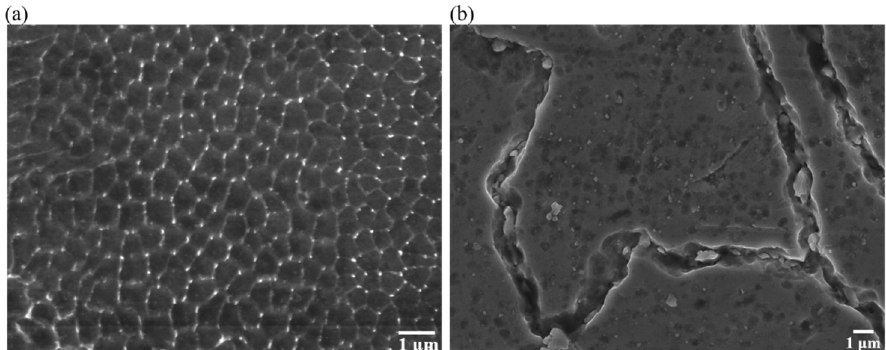
Figure 10. SEM images in the fully dense ( a ) as-built and ( b ) heat-treated CoCrMo alloys.